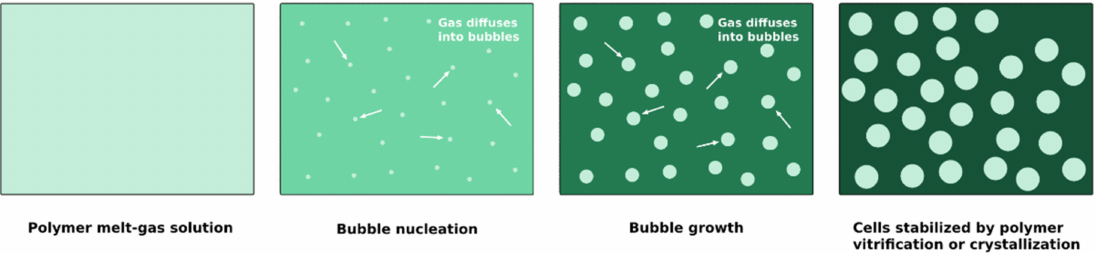
Figure 1. Cell nucleation, growth, and